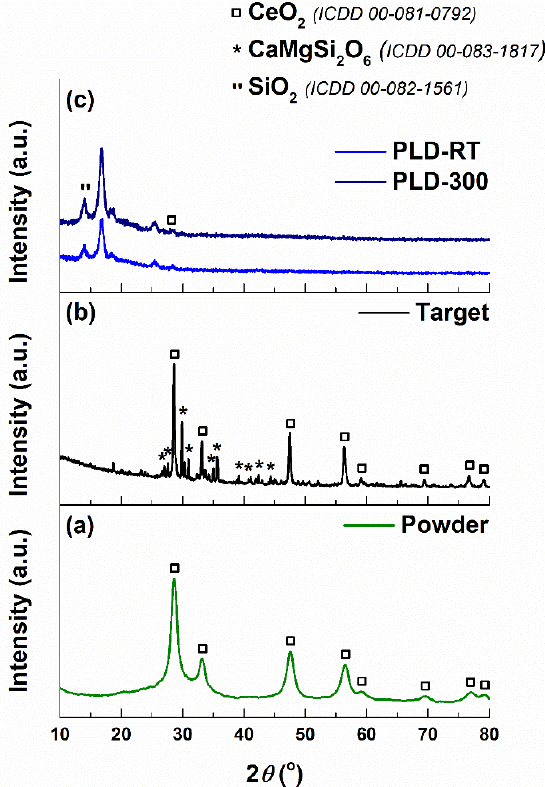
Figure 6. XRD patterns of: ( a ) powder, ( b ) target and ( c ) PLD-RT and PLD-300 thin films.